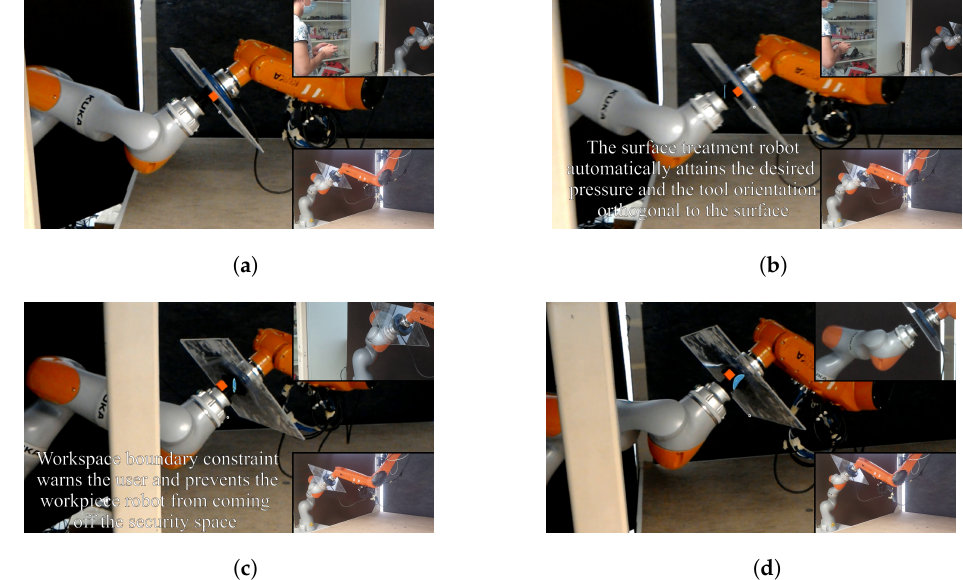
Figure 13. Third experiment: frames of the video showing the performance of the 3D boundary and the WR reference hologram. See the video at https://media.upv.es/player/?id=17d88200-8f0b-11ec- be22-d786eca82090 (accessed on 26 April 2022) [83]. ( a ) Video: 0 m 22 s. ( b ) Video: 0 m 24 s. ( c ) Video: